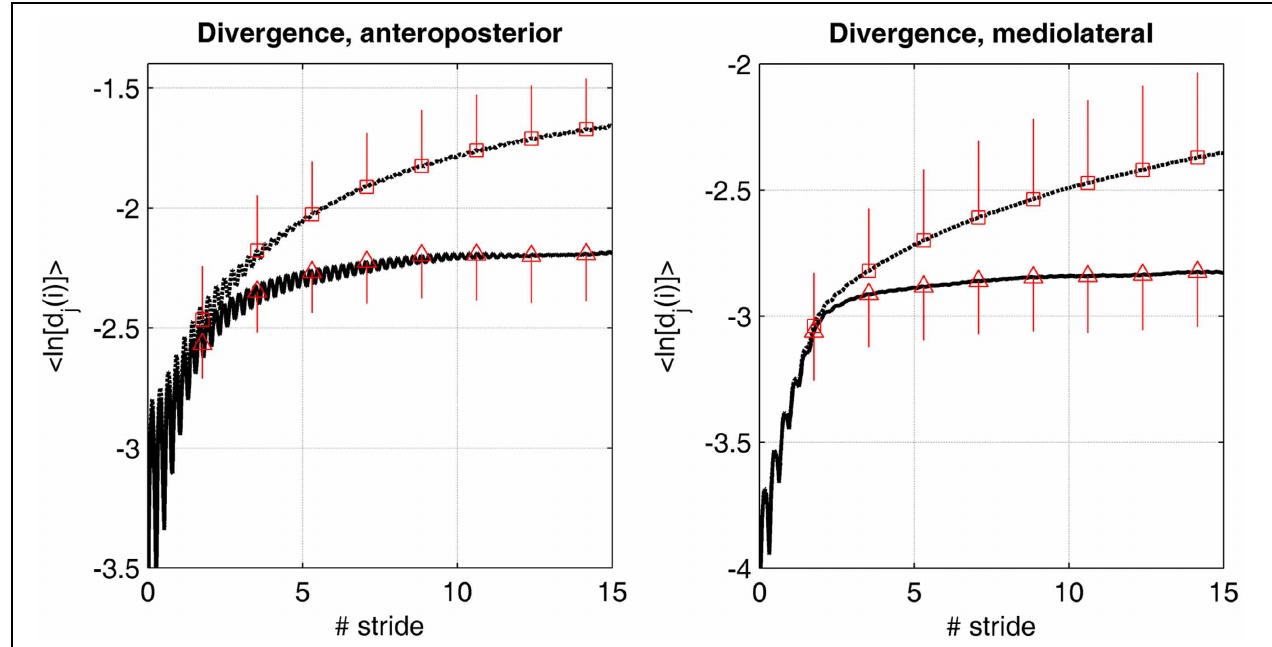
normalized by the average stride time (1.14s). Discontinuous lines (squares) are the results for the treadmill only condition. Continuous lines (triangles) are the results for the dual cueing condition (treadmill + rhythmic auditory cueing). Mean value at 100, 200, 300, 400, 500, 600, 700, and 800 samples are shown (squares and triangles) with the corresponding SD (vertical lines, N =